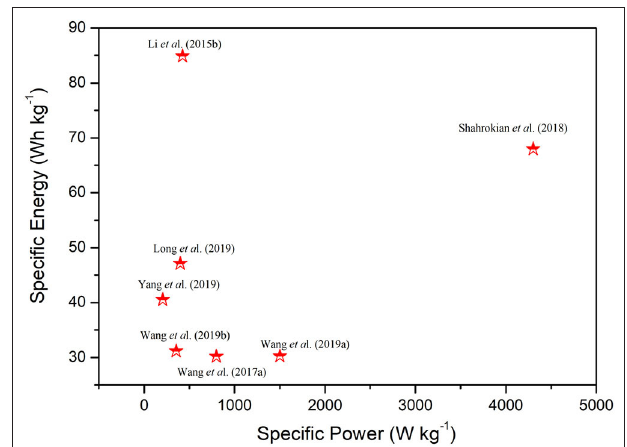
FIGURE 10 | Ragone plot summarizing specific energy and specific power of some of the reported literature on Ni-Co LDHs combining with carbon-based